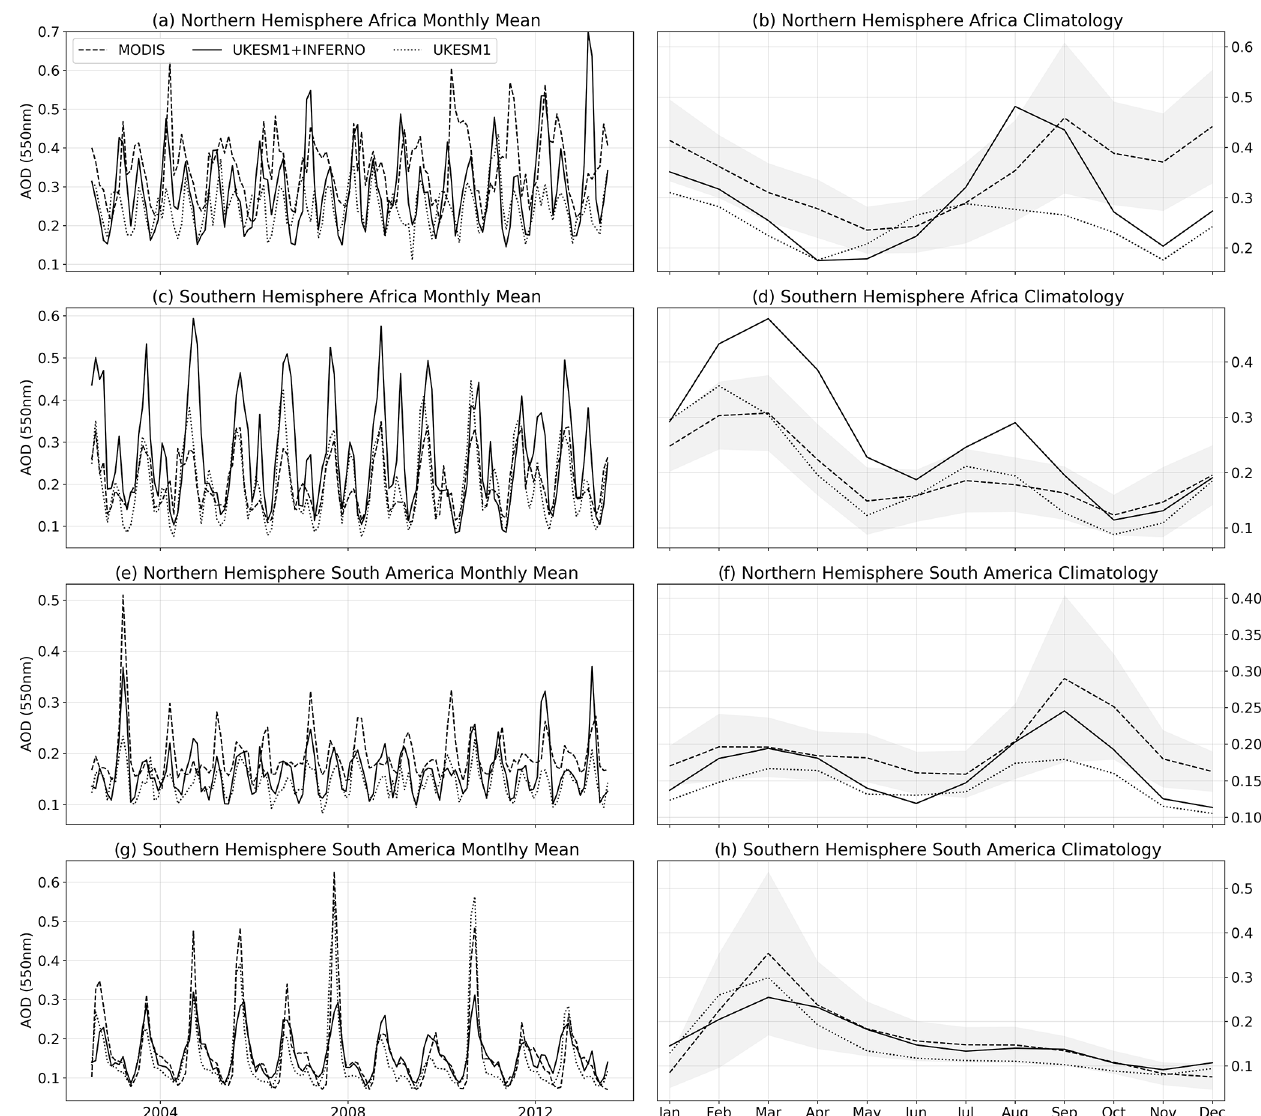
Figure 12. Aerosol optical depth at 550nm for the period 2003–2012 (a) monthly mean time series and (b) climatology of monthly means for the NHAF region, (c) monthly mean time series and (d) climatology of monthly means for the SHAF region, (e) monthly mean time series and (f) climatology of monthly means for the NHSA region, and (g) monthly mean time series and (h) climatology of monthly means for the SHSA region – UKESM1+INFERNO (solid line), UKESM1 (dotted line) and MODIS (dashed